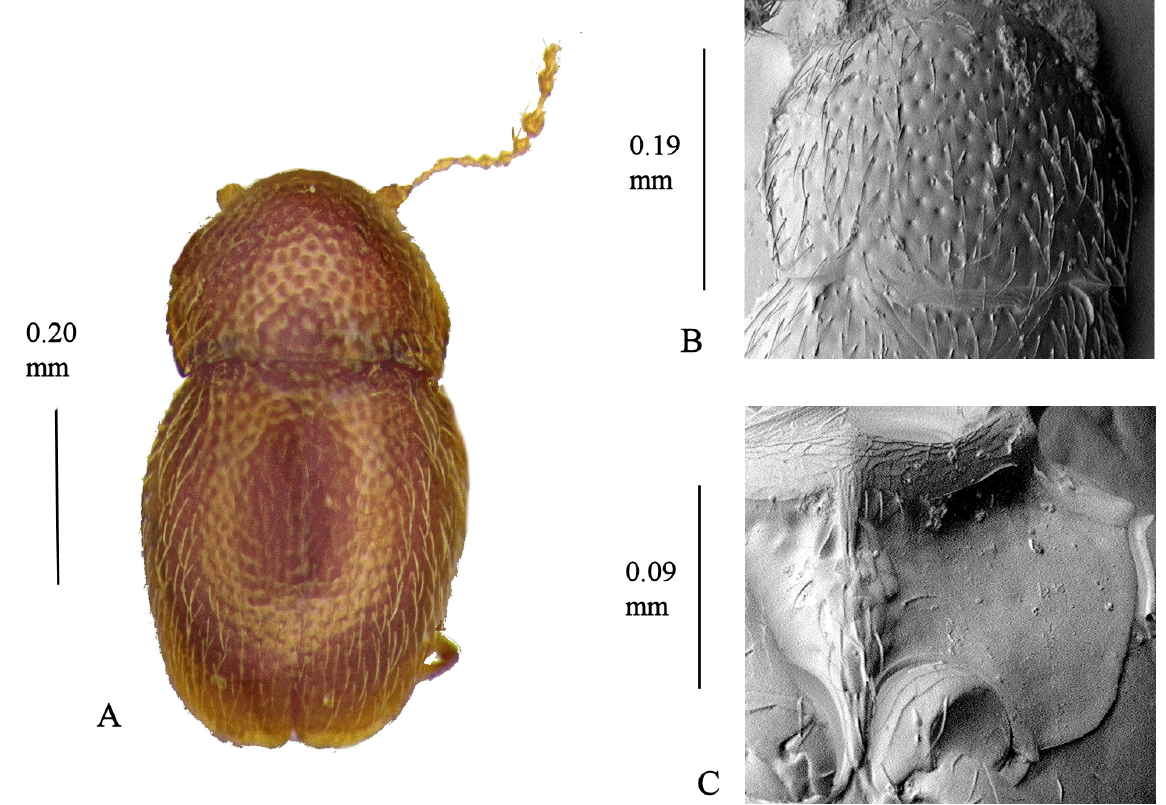
Fig. 50 . Cissidium ikeuchii Sawada, 2008. A . Habitus. B . Pronotum, × 485. C . Mesoventrite showing median process of collar, mid keel, keel and lateral margin, ×